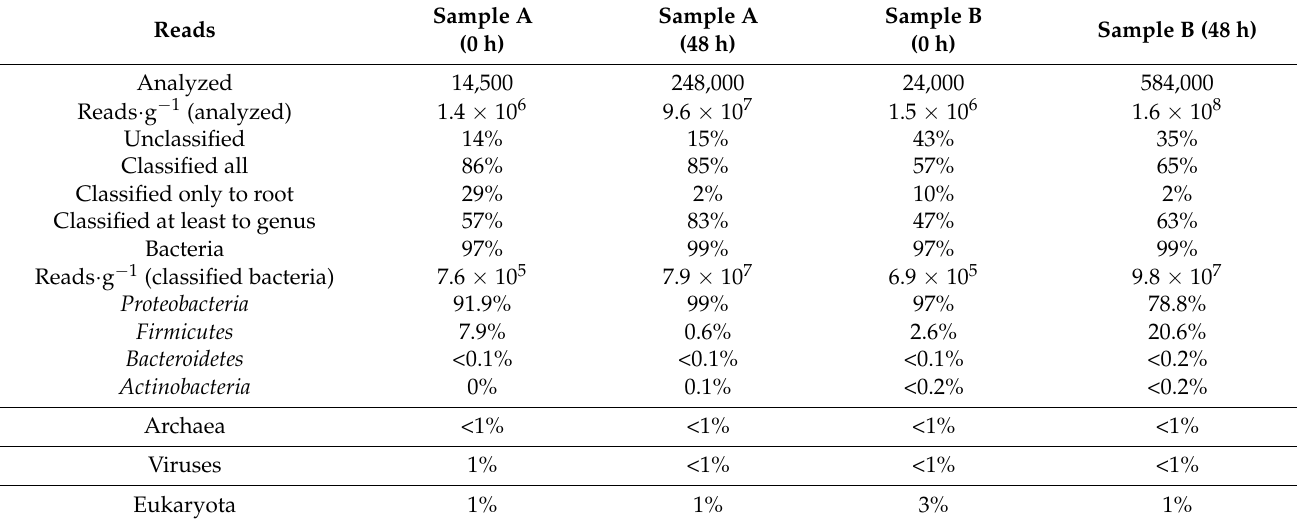
Table 1. Overview of reads obtained by nanopore sequencing for sample A and B after and before